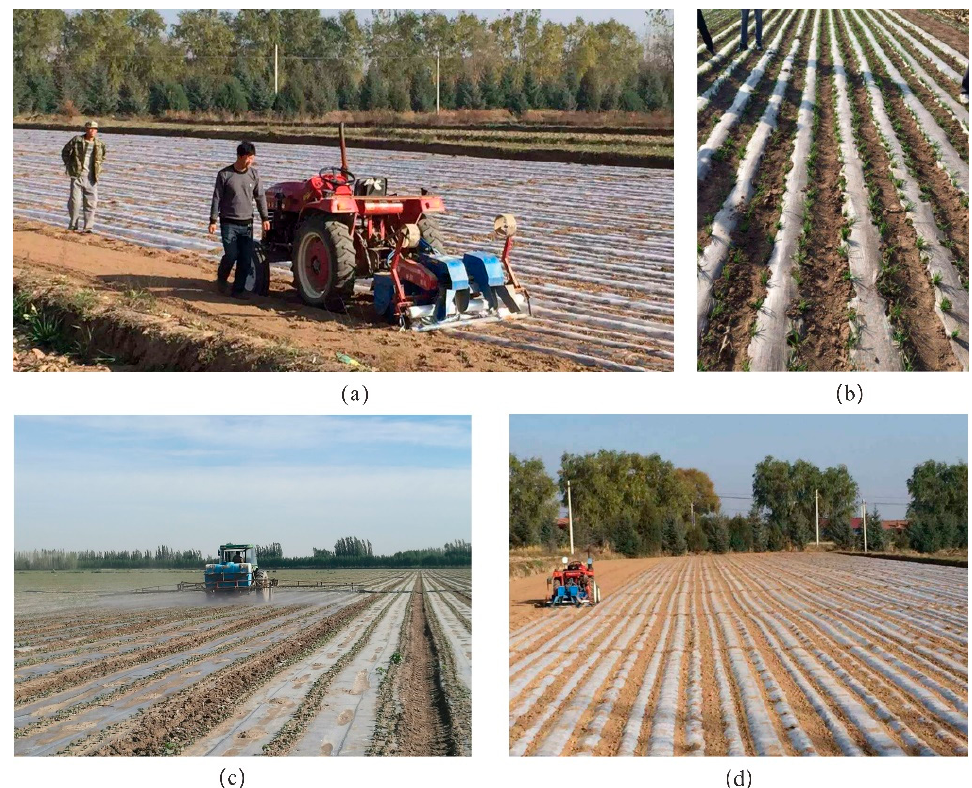
Figure 2. Plastic-mulched landcover presences in the study area. ( a – d ): some photos of PML in Shihezi, Xinjiang, China.